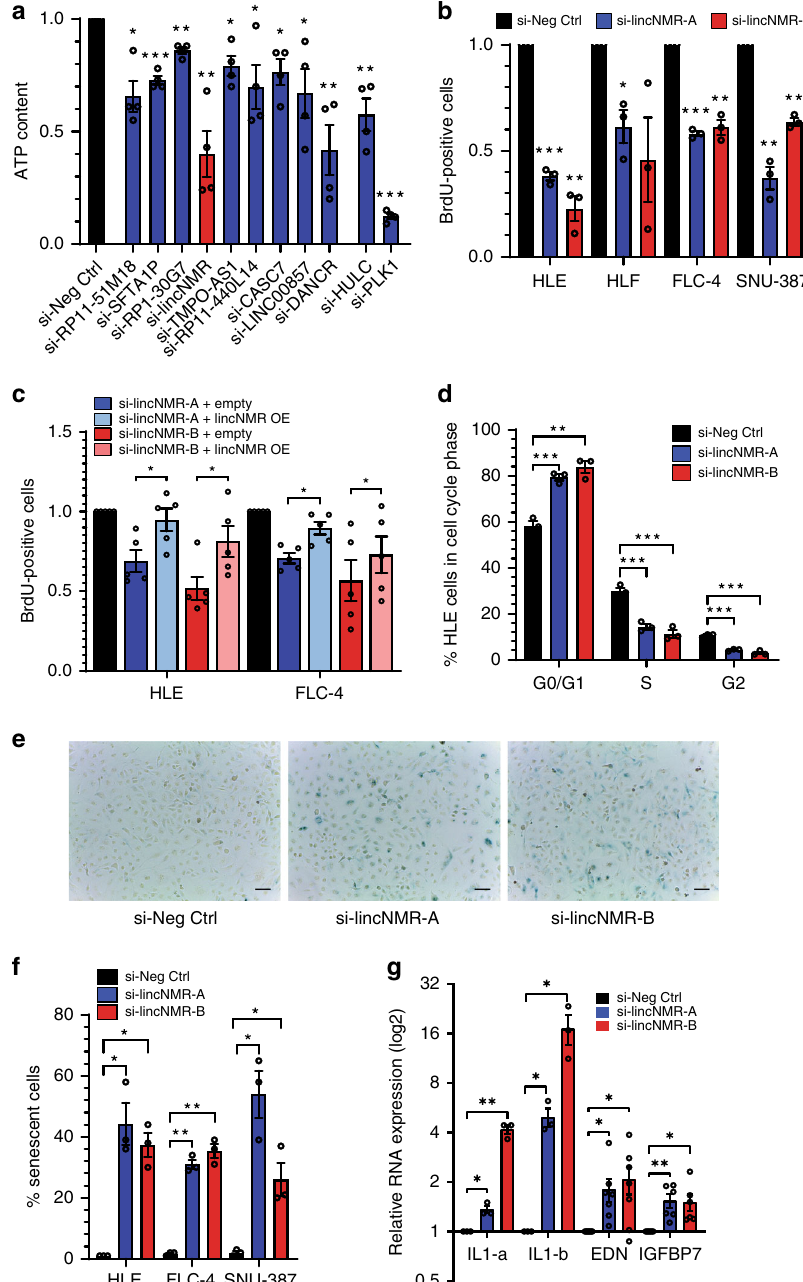
Fig. 1 LincNMR depletion impairs cell viability, cell proliferation and induces senescence. a Impact of depletion of selected lncRNAs with 10 nM siPOOLs on cell viability as determined by CellTiter-Glo measuring the cellular ATP content after 72 h in HLE cells ( n = 4). si-HULC and si-PLK1 served as positive controls. b Depletion of lincNMR with 10 nM of two independent siPOOLs invokes a strong proliferation defect in four liver cancer cell lines (HLE, HLF, FLC- 4, and SNU-387) 72 h post transfection ( n = 3). c Overexpression of lincNMR rescues the proliferation defect induced by lincNMR silencing in two different liver cancer cell lines, HLE and FLC-4. Data show BrdU assay readout at 72 h after lincNMR knockdown (KD), and 66 h after lincNMR overexpression (OE). Data shown are normalized to si-Neg Ctrl siPOOL transfected with empty vector pcDNA3.1 ( n = 5). Signi fi cance was calculated by paired, two-tailed t test with * P < 0.05. d Silencing of lincNMR with 10 nM siPOOLs induces cell cycle arrest in the G0/G1 phase shown by fl ow cytometry 72 h post transfection in HLE cells ( n = 3). Analysis was performed using FlowJo v10 software. e Representative microscopic images showing increased β -Gal activity indicating senescence in HLE cells 96 h post lincNMR knockdown with 10 nM siPOOLs ( n = 3). The scale bar represents 100 µ m. f Bar graph representing percent β - Gal-positive cells in multiple liver cancer cell lines after lincNMR depletion ( n = 3). g Induction of senescence-associated secretary phenotype (SASP) markers IL-1a,IL-1b, EDN, and IGFBP7 determined by RT-qPCR at 72 h after lincNMR knockdown in HLE cells with 10 nM siPOOLs ( n = 3). a – d , f , g Data represent mean, and error bars represent SEM. a , b , d , f , g Signi fi cance was calculated by unpaired, two-tailed t test with * P < 0.05; ** P < 0.01; *** P < 0.001. a – c , g Data shown were normalized to negative control